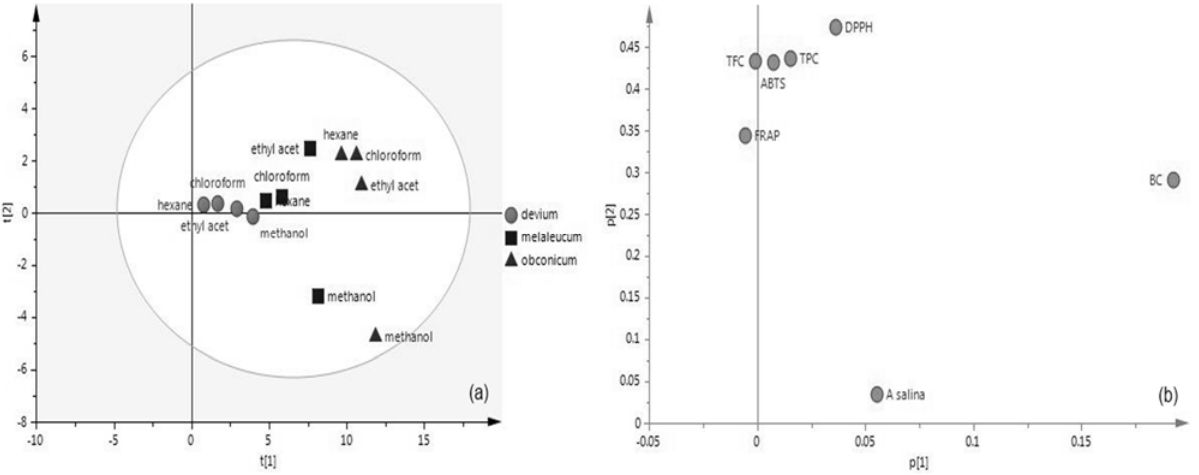
Figure 2. PCA plot of the scores ( a ) and loadings ( b ) of the Helichrysum